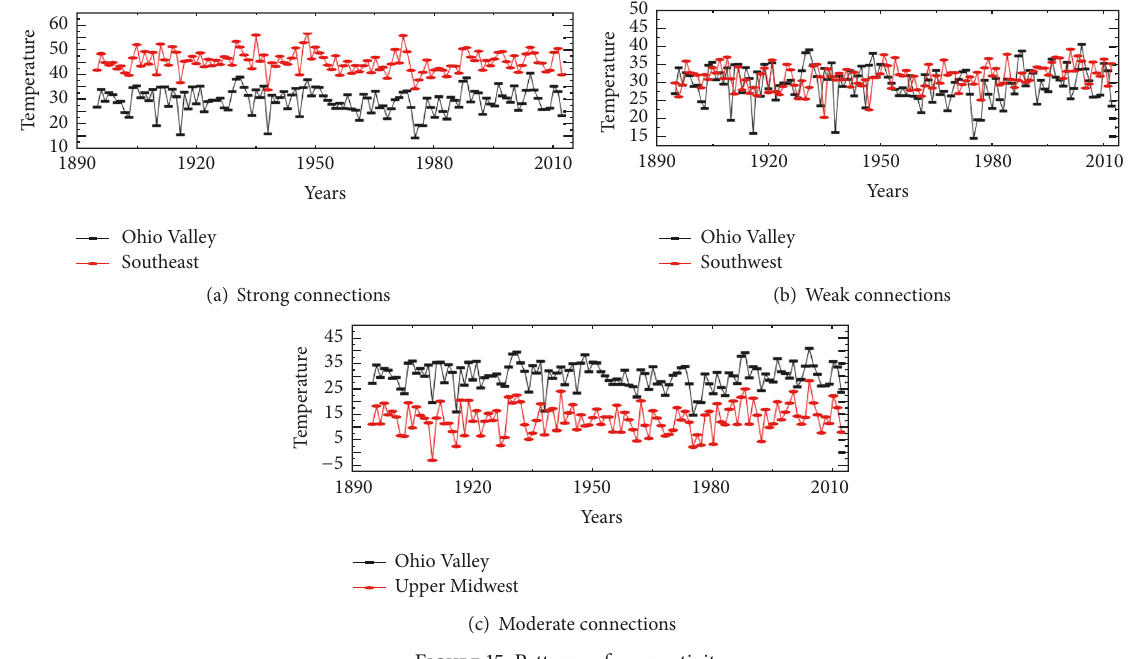
Figure 15: Patterns of connectivity.